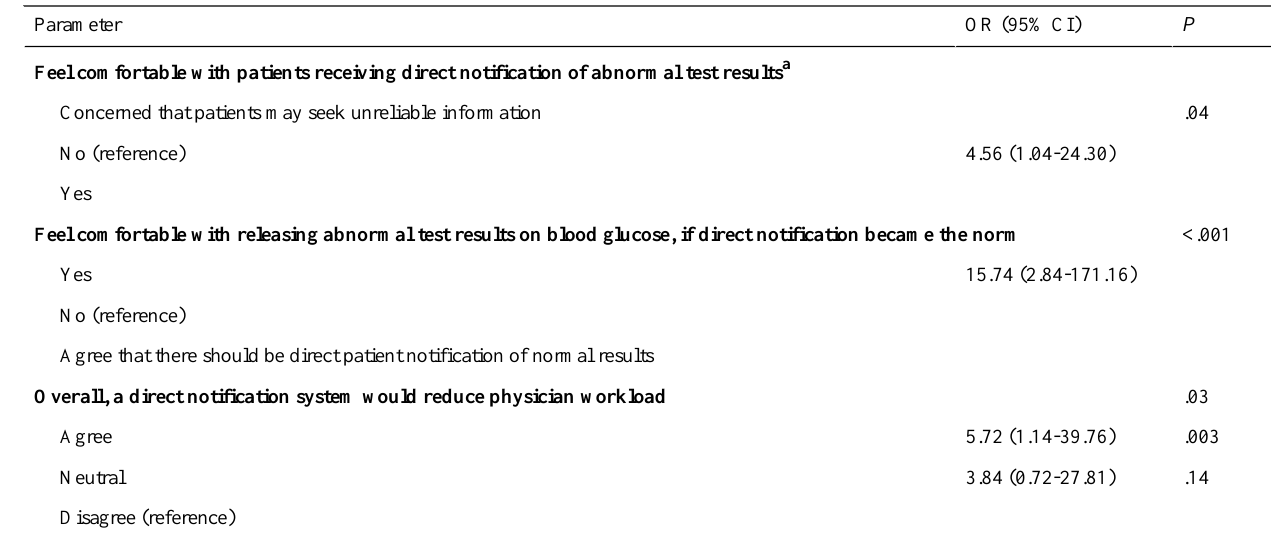
Table 5. Logistic regression exploring predictors of emergency physician comfort with direct patient notification of abnormal test results and agreement with patient notification of normal test